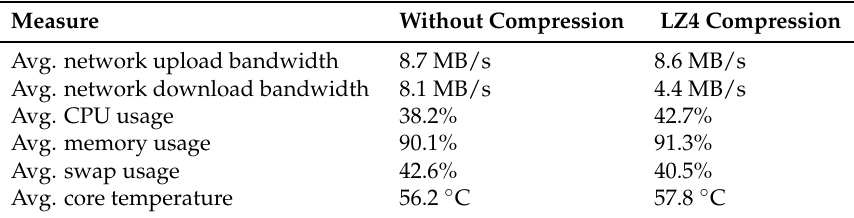
Table 2. Single-Board-Computer micro data-center performance results without compression vs. using compression.